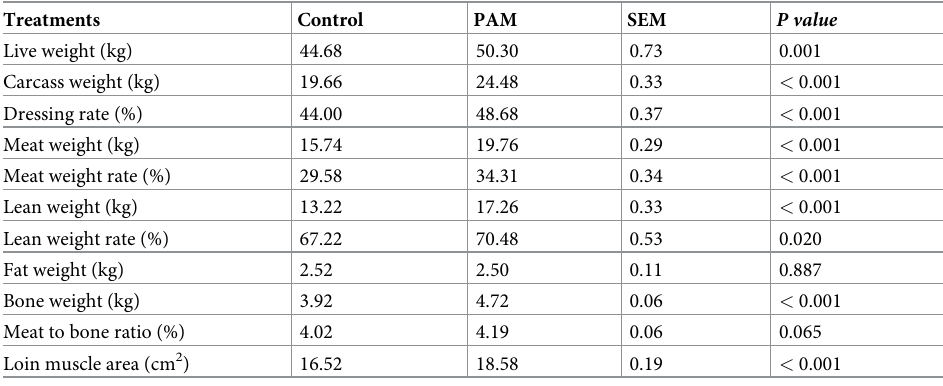
Table 5. The effect of supplementation with polyacrylamide on the slaughter performance of lambs.